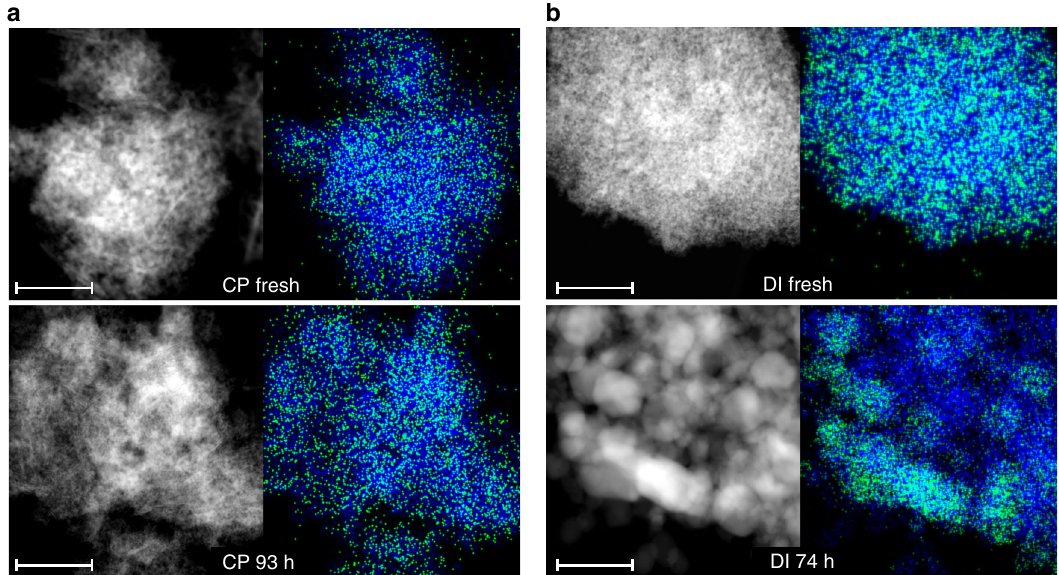
Fig. 2 Microscopy analysis of palladium-promoted In 2 O 3 catalysts. HAADF-STEM images and corresponding EDX maps of indium (blue) and palladium (green) for the catalysts produced by a CP and b DI with 0.75 wt.% Pd in fresh form and after the tests depicted in Fig. 1b. The scale bar in all panels is 50